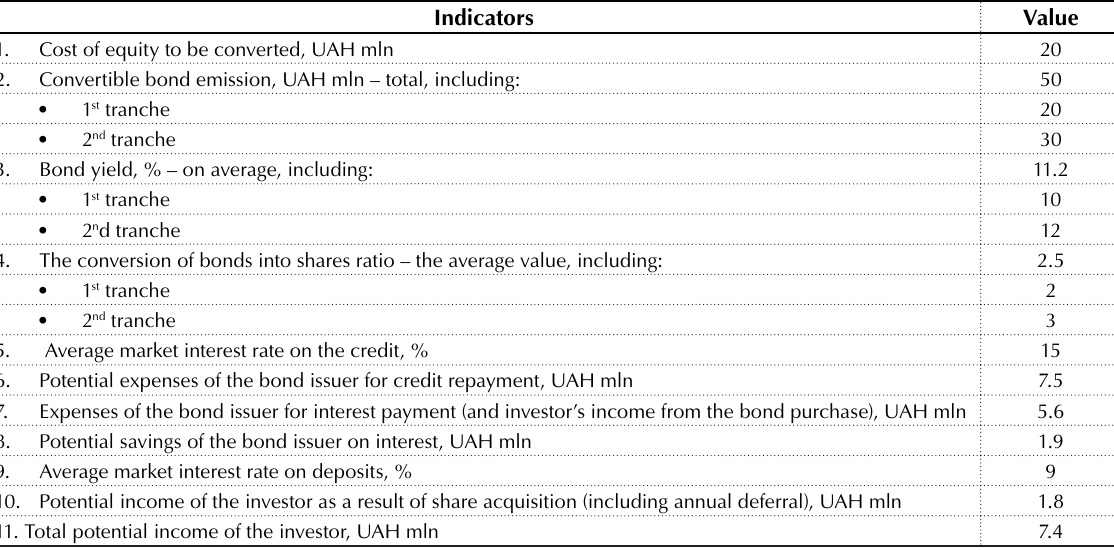
Table 1. Conditional calculation of the income of a bond issuer and an investor when using convertible bonds (on an annualized